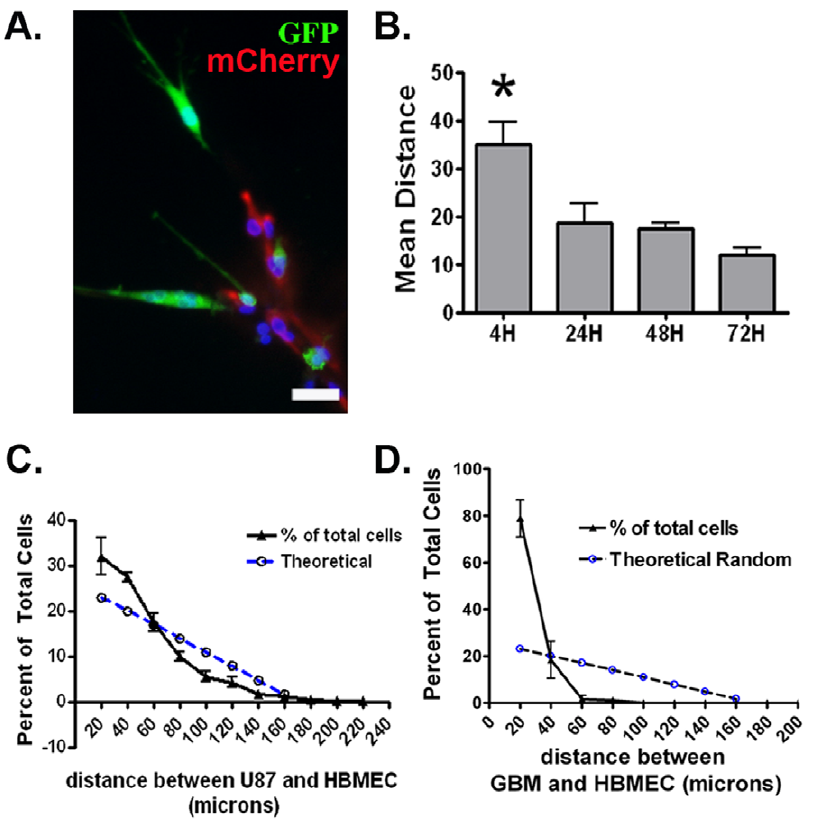
Figure 3. U87 and primary GBM cells localize to the peri-endothelial domain when plated with HBMECs on Matrigel. ( A ) Twenty-four hours after establishing a capillary-like network of mcherry-expressing HBMECs in Matrigel, eGFP-expressing U87 cells were added to the culture. Within 24 hours U87 cells were seen in physical contact with HBMECs. Scale bar=50 microns. ( B ) The mean distances between U87 cells (500 to 800 cells) and HBMECs were calculated at different time points after the addition of the tumor cells to the HBMEC networks. There was a significant increase in co-localization (reduction in mean distance) within 24 hrs, which was maintained over a 72 hr period. *=p , 0.05 as determined by one way ANOVA for the means of three separate experiments involving 500–800 measurements per experiment. ( C ) The distance between approximately 1000 eGFP-expressing U87 cells and mCherry fluorescent protein-expressing HBMECs in co-culture (24 hrs) was measured and the distribution was plotted as the percentage of total cells in 20 micron increments (black triangles). More than 50% of the total U87 cells in the culture were within 40 microns of an endothelial cell. A theoretical plot of a random distribution of cells is shown (open circles). ( D ) The distance between GFAP positive GBM cells and mCherry fluorescent protein-expressing HBMECs in co-culture were measured and the distribution was plotted as the percentage of total cells in 20 micron increments (black triangles). Error bars represent SEM from three independent experiments involving three different GBM isolates. Approximately 500 GBM (GFAP positive) cells were counted. Nearly 80% of the GFAP positive GBM cells in the culture were within 20 microns of an endothelial cell. A theoretical plot of a random distribution of cells is shown (open circles).